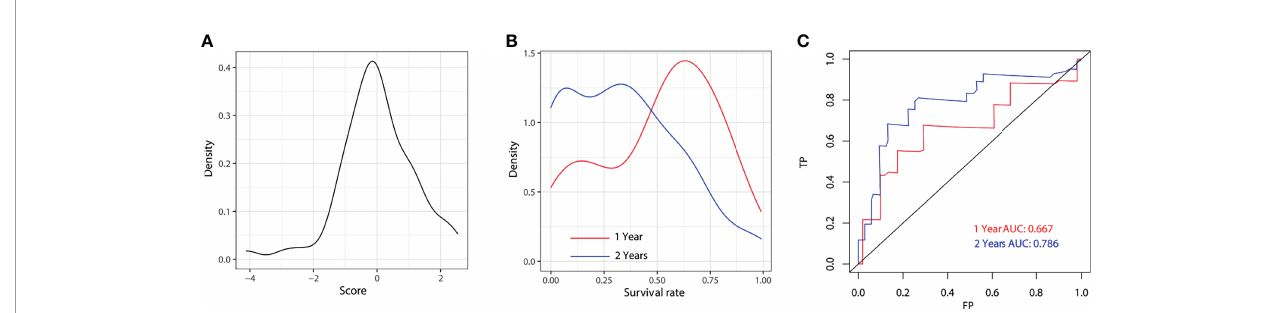
FIGURE 7 | External validation for 1-year and 2-year of the model. Distribution plot for score (A) , 1-year and 2-year survival rate (B) . ROC of the nomogram for 1- year and 2-year external validation (C) . AUC, area under the curve; FP, false positive; TP,